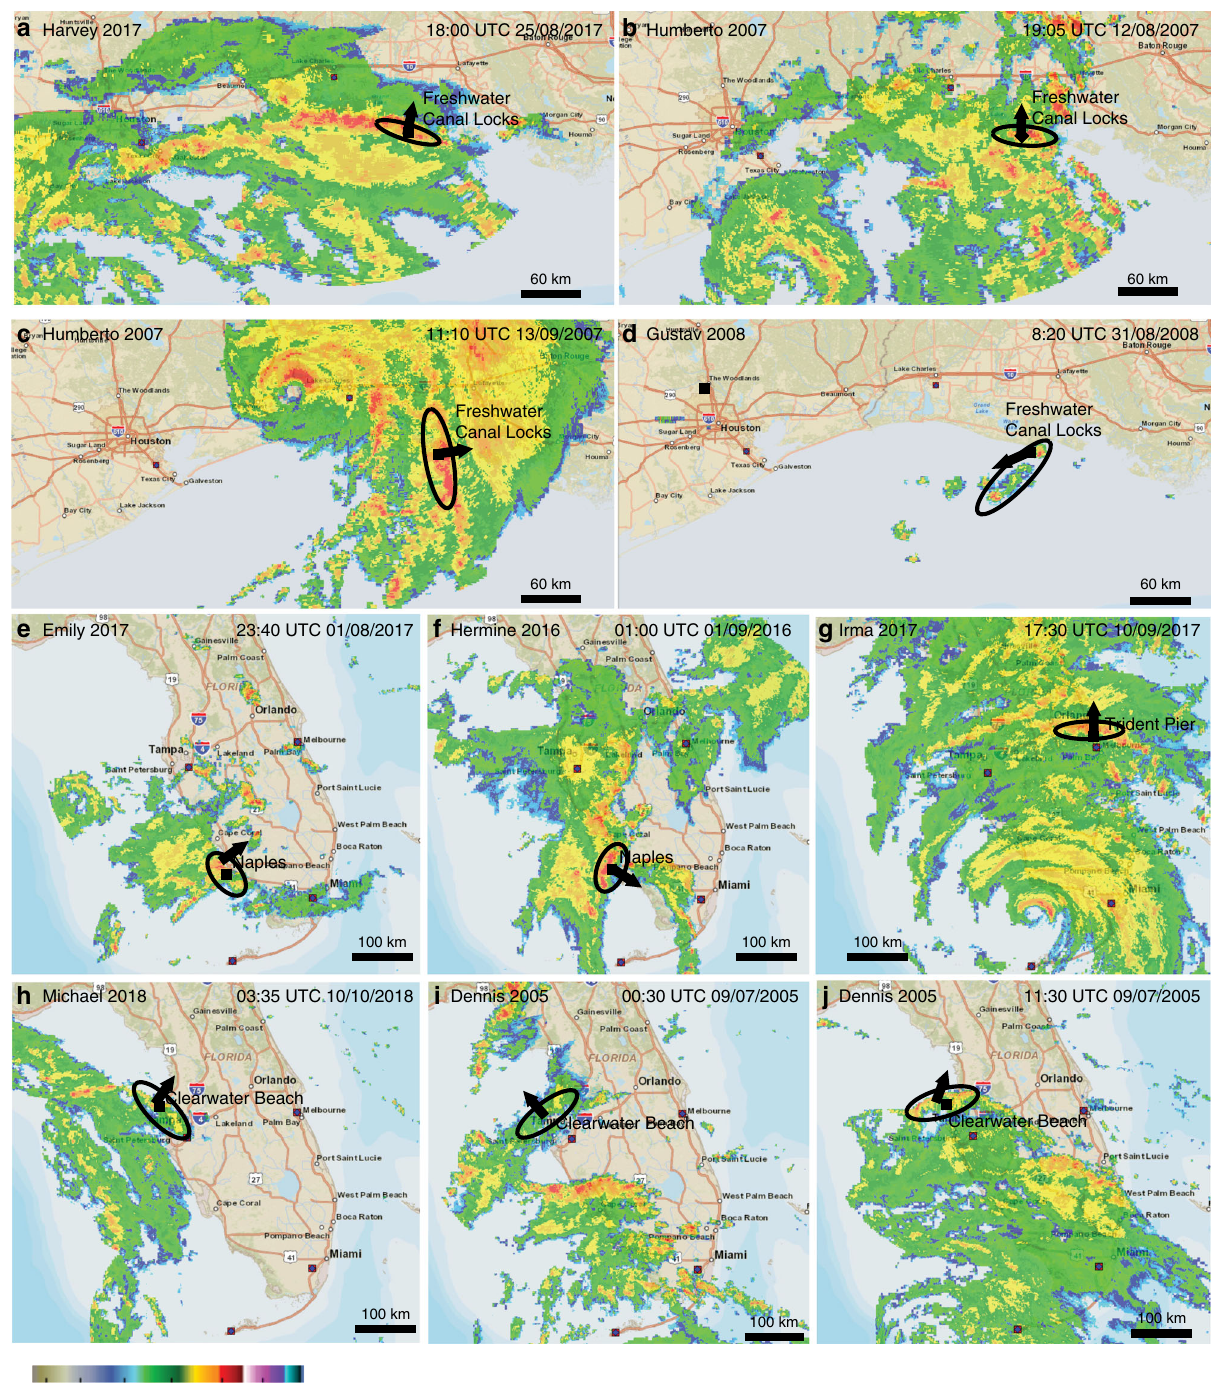
Fig. 4 NEXRAD observations during tropical cyclone-induced meteotsunamis. Atmospheric radar re fl ectivity mosaics during the eight most extreme meteotsunami events from the 1998 – 2018 Atlantic hurricane seasons. In each panel, the rainband that produced the main meteotsunami is shown within the black ellipse and the direction of propagation is represented with the black arrow. Dates are indicated as Day/Month/Year. dBZ decibel relative to Z (logarithmic dimensionless unit of radar re fl